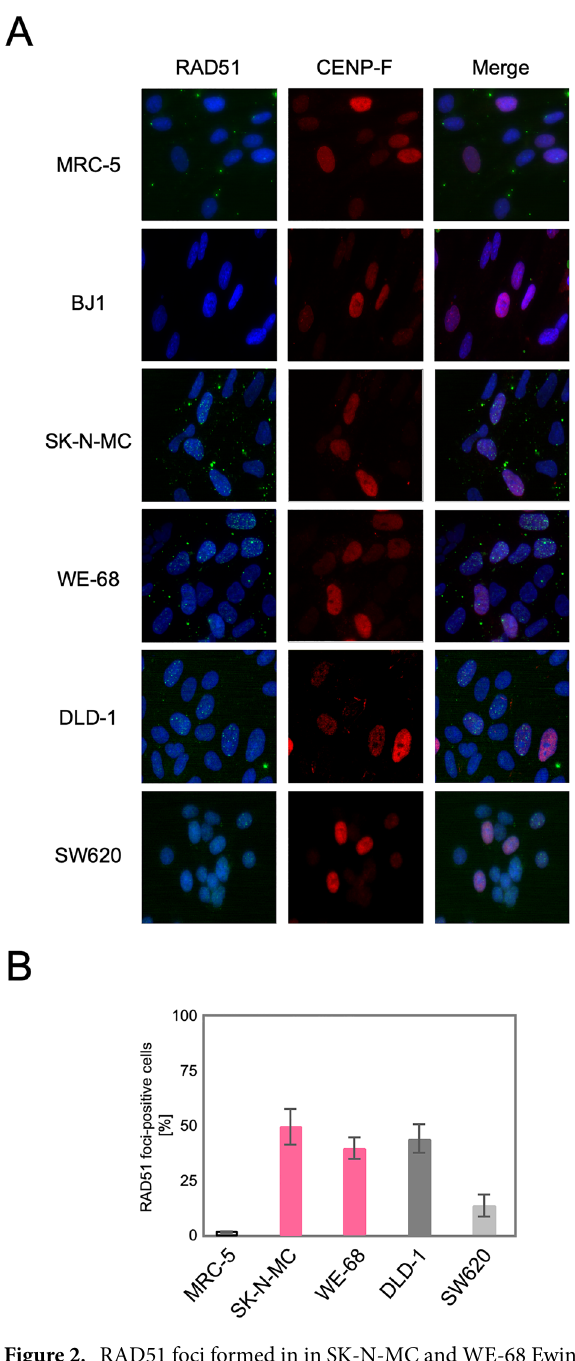
( A ). RAD51 foci-positive cells were counted in ten visual fields (see also “Materials and methods” section). In three independent series of observations, the means and standard deviations were calculated. The results are compared in a bar chart ( B